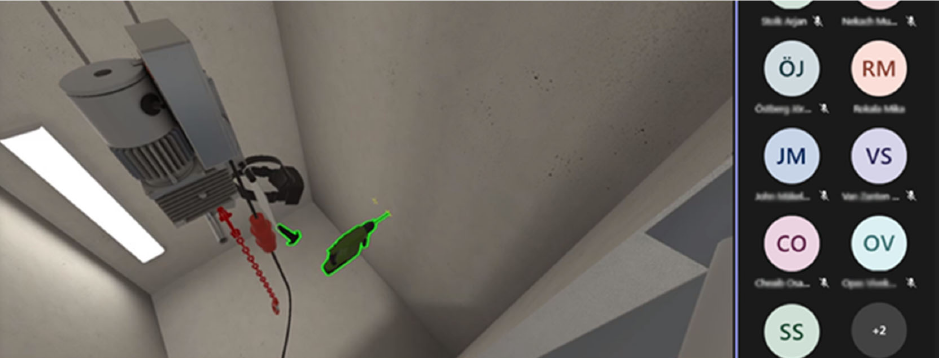
Figure 1. Asymmetric use of VR training system while in a remote training session via Microsoft Teams.